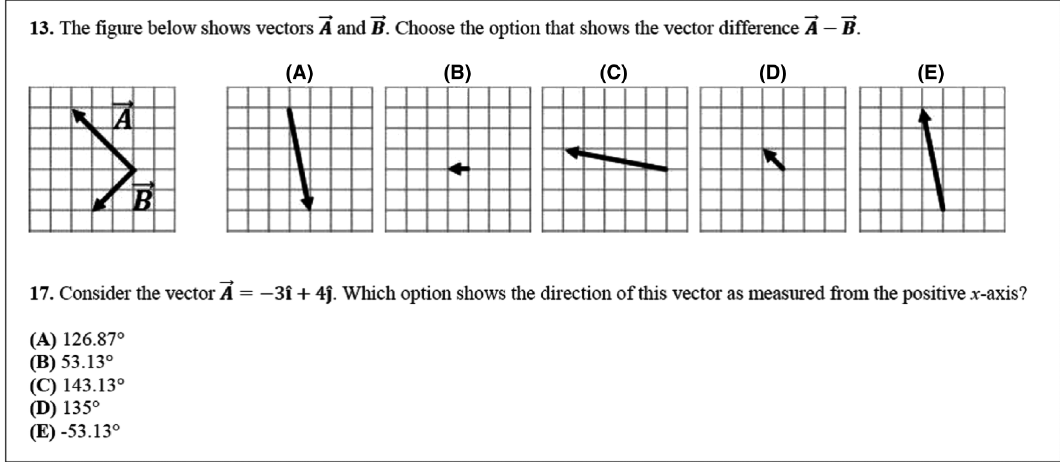
FIG. 1. Item 13 (graphical subtraction of vectors in 2D) and item 17 (calculation of direction of a vector written in unit-vector notation) of the